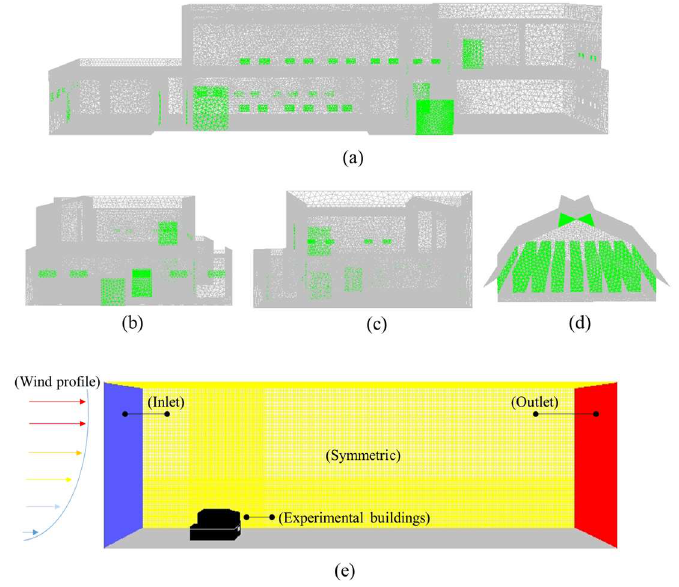
Figure 7. Design of the CFD model for the analysis of natural ventilation performance: ( a ) front view of the experimental building, ( b ) side view (east), ( c ) side view (west), ( d ) wide-span greenhouse, and ( e ) computational domain (same methodology with [43, 45]